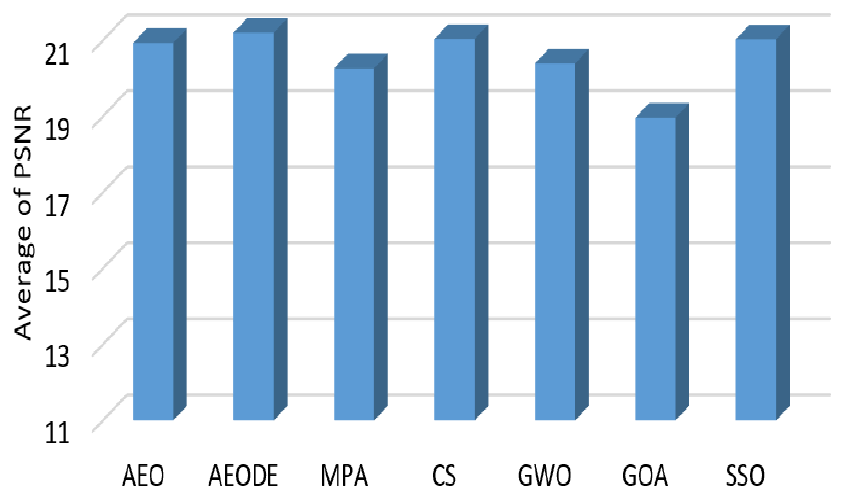
Figure 6. PSNR values of AEODE and other optimization